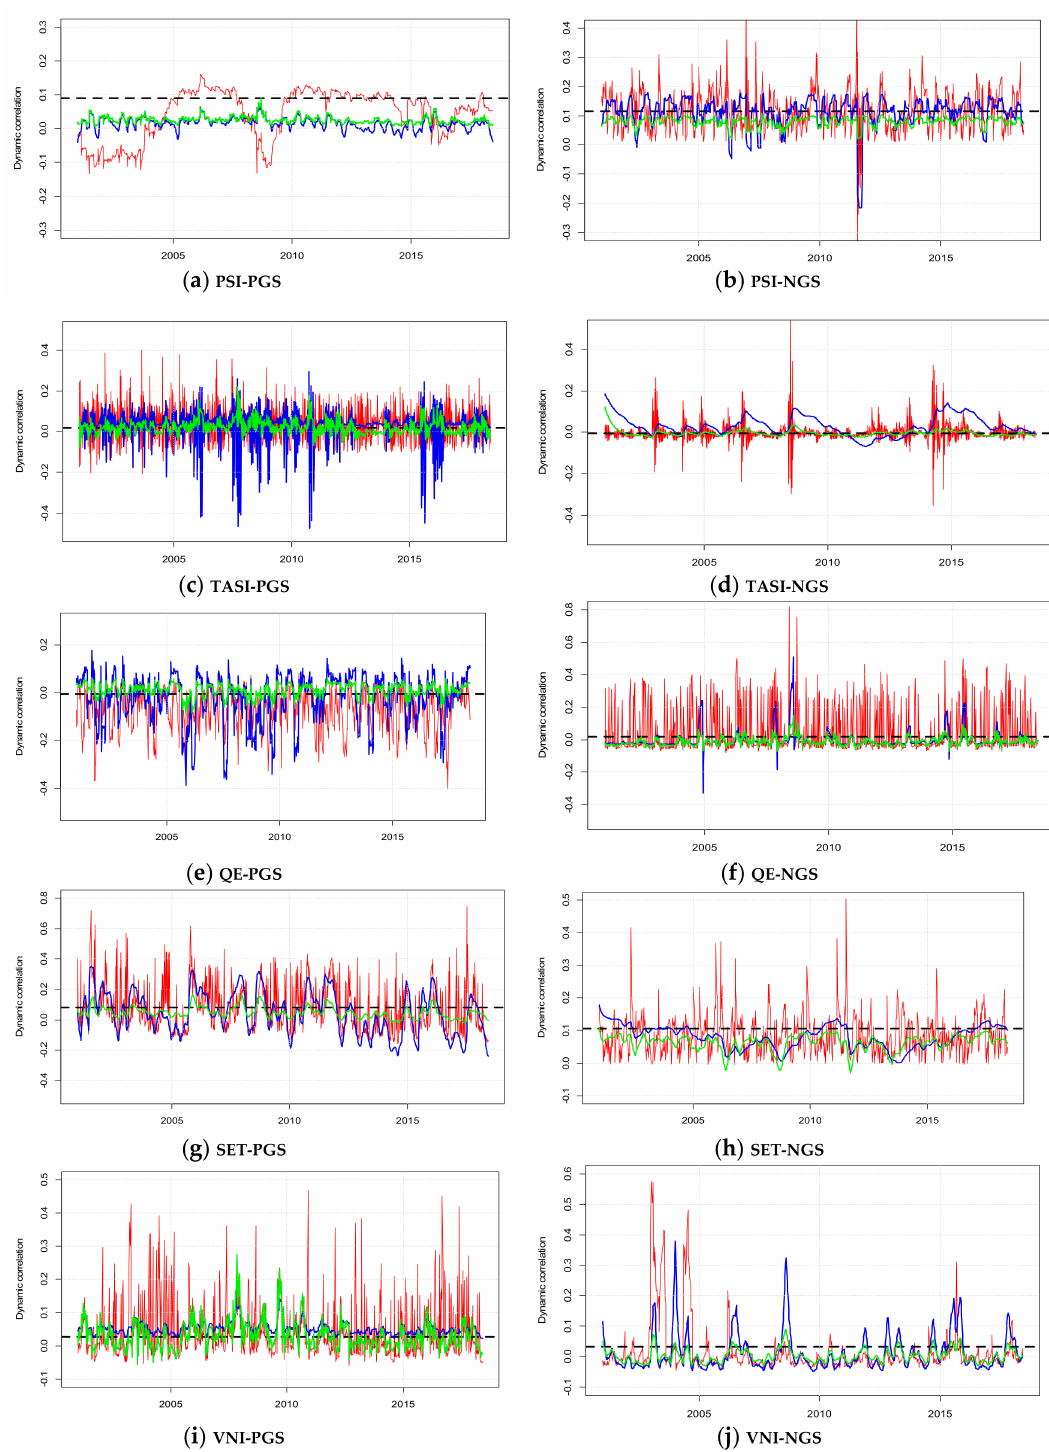
Figure 4. Time-varying Copula dependence measures. The graphs in the left column plot the time-varying Kendall’s tau between stock volatility and positive gold shock, while those in the right column plot the time-varying Kendall’s tau between stock volatility and negative gold shock for PSI , TASI , QE, SET, and VNI markets: The black dashed line is the Static Copula, the green line is the Dynamic Copula, the red line is the MSDC, and the blue line is the